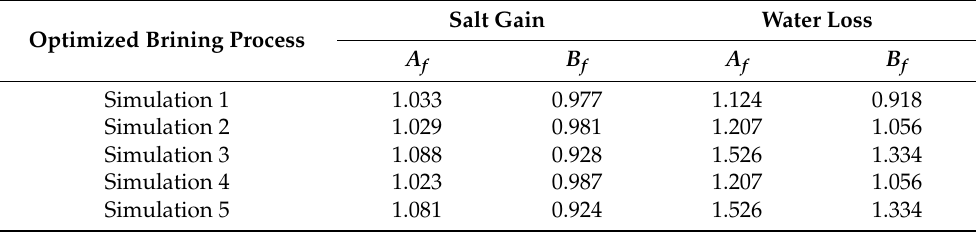
Table 5. Accuracy ( Af ) and bias factor ( Bf ) values for the second-order polynomial regression model fitted with the observed quality values for SG and WL under optimized brining process